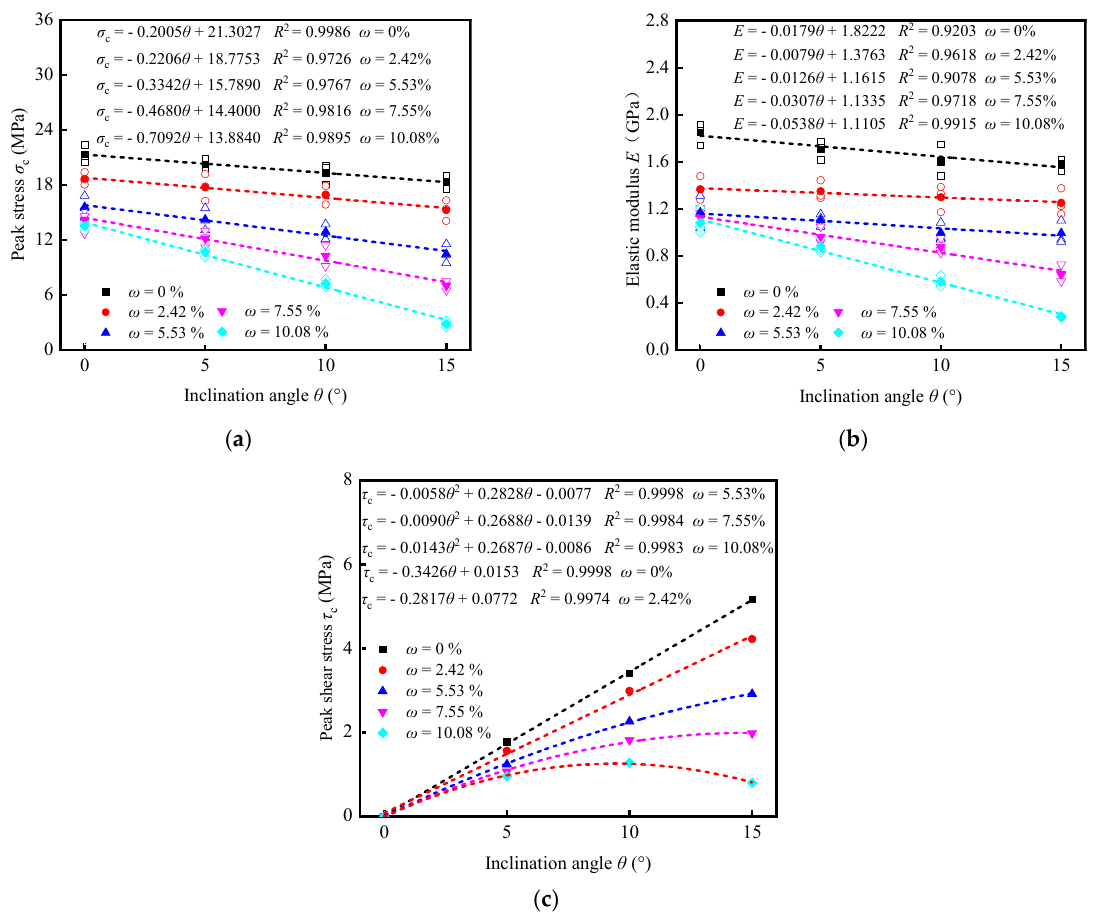
Figure 7. Variation law of mechanical characteristic parameters of water-bearing coal specimens with the inclination angle: ( a ) peak stress σ c ; ( b ) modulus of elasticity E ; ( c ) peak shear stress τ c . (1) Peak stress σ c